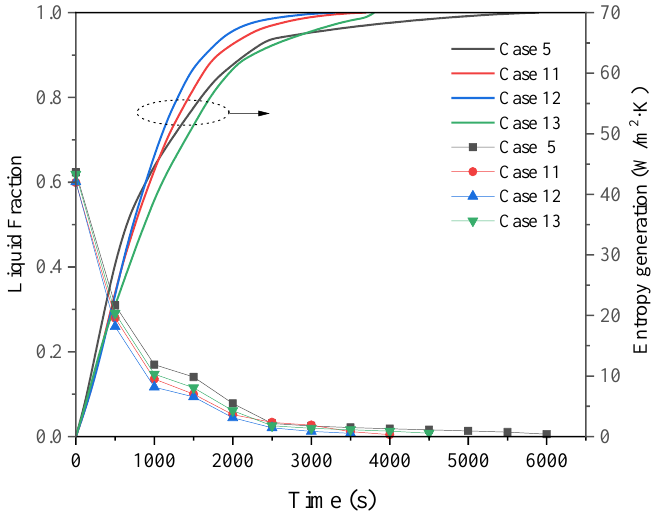
Figure 19. Thermal penetration and thermal uniformity for Cases 5, 11 – 13.